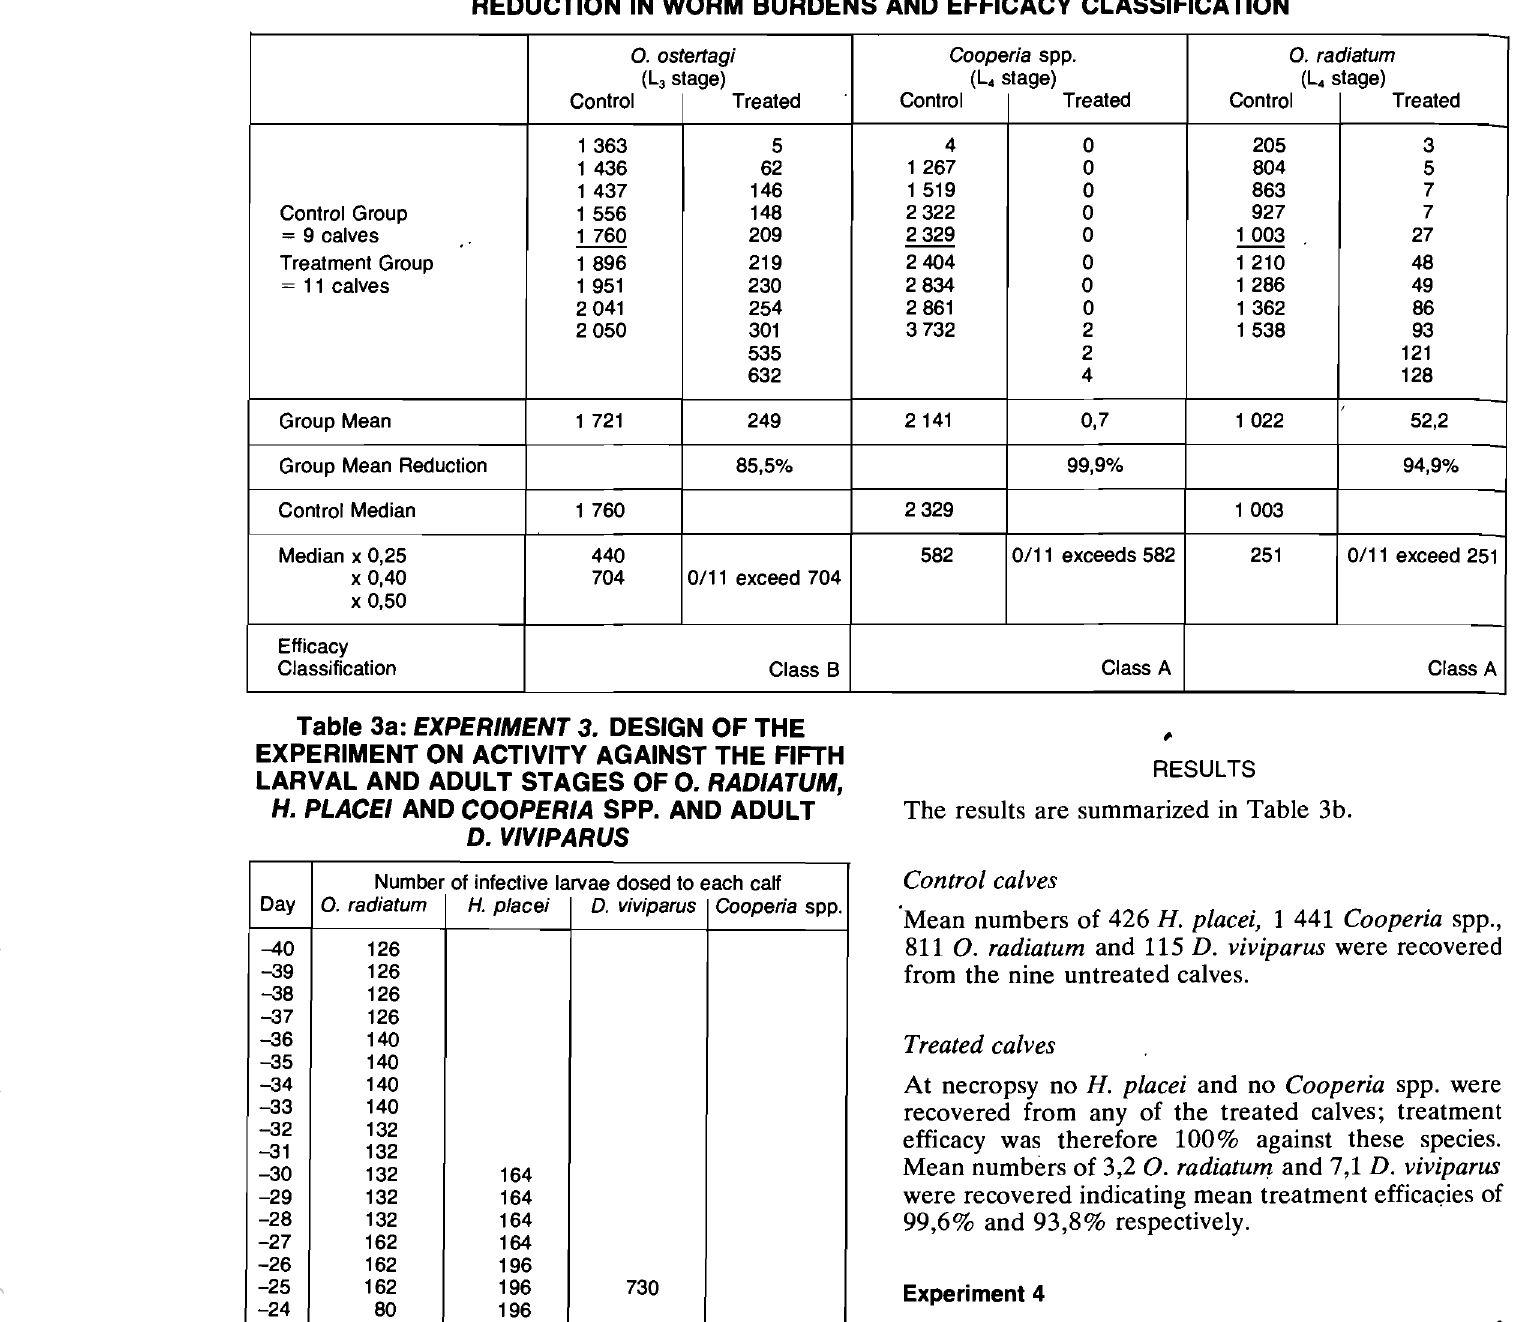
Table 2b: EXPERIMENT 2. NUMBER OF WORMS RECOVERED AT NECROPSY, PERCENTAGE REDUCTION IN WORM BURDENS AND EFFICACY CLASSIFICATION